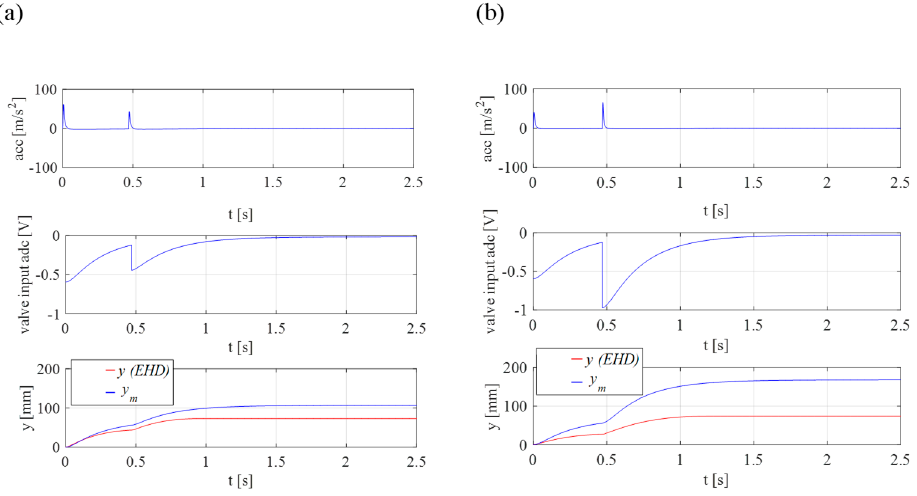
Figure 6. Simulation results for two values of supply pressure for the position y = 75 mm: ( a ) p 0 = 11 MPa; ( b ) p 0 = 5